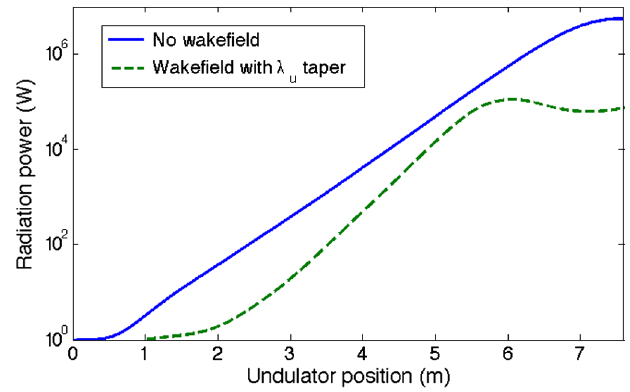
FIG. 21. 3D FEL simulation of the average microundulator radiation power across the electron bunch with and without longitudinal wakefields.